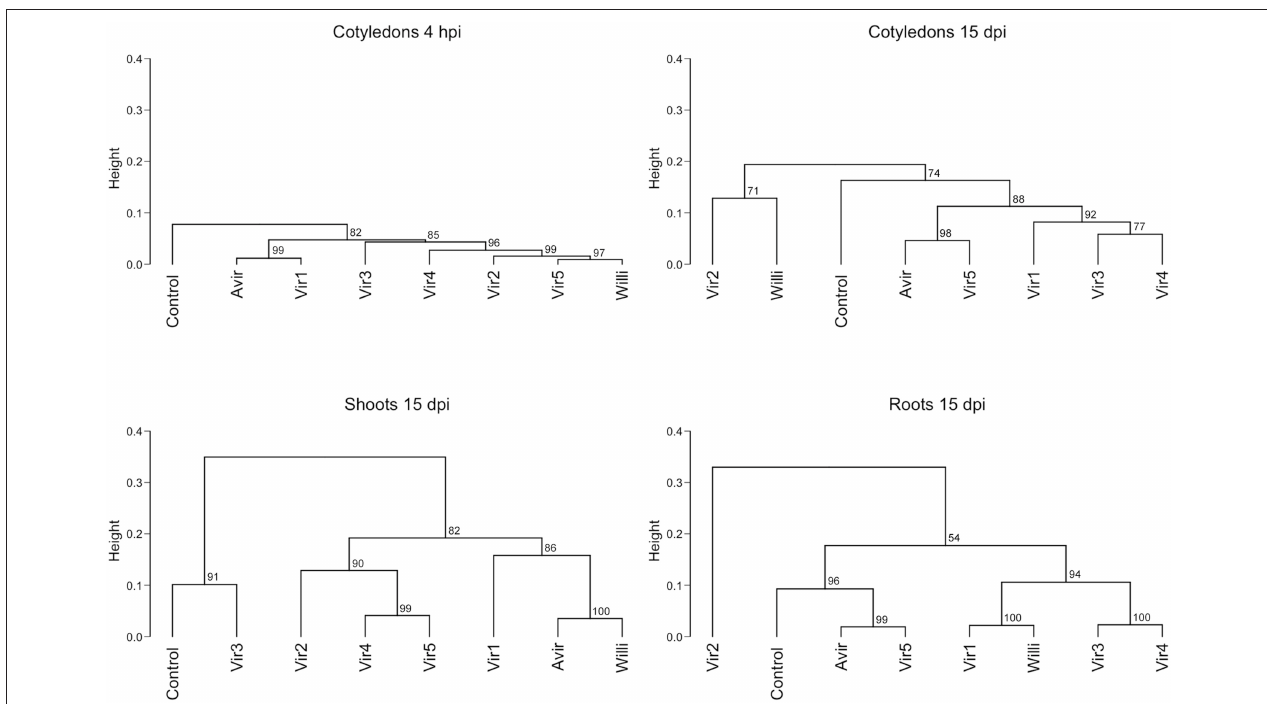
FIGURE 6 | Hierarchical clustering of cytokinin content in pea cotyledons, shoots and roots inoculated with different bacterial strains. Cluster analysis is based on cytokinin type and level detected in cotyledons at 4h post-inoculation (hpi), and in cotyledons, shoots and roots at 15 days post-inoculation (dpi) with an avirulent strain, six virulent strains, and mock-inoculated control, from four biological replicates. Dendrograms were constructed using Pearson correlation coefficients for the distance matrix and average linkage as the clustering method of log-transformed data, with bootstrapping of 1,000 iterations. Height represents the distance between nodes—the greater the height the greater the dissimilarity between treatments. Numbers in red indicate the unbiased approximate p -values (%), computed by multiscale bootstrap resampling using the pvclust R package ( Suzuki and Shimodaira, 2006). Strains are as described in Stange et al. (1996): Avirulent—avirulent strain 593; Vir 1: virulent strain 594 (210kb linear plasmid similar to virulent strain 602); Vir 2: 599 (same RFLP pattern to 602 but linear plasmid not detected); Vir 3: 666 (has a circular plasmid); Vir 4: 606 (130kb linear plasmid). Vir5: R. fascians sp. Leaf225 isolated from non-symptomatic Arabidopsis leaves and Willi: Williamsia sp. Leaf354, also isolated from non-symptomatic Arabidopsis